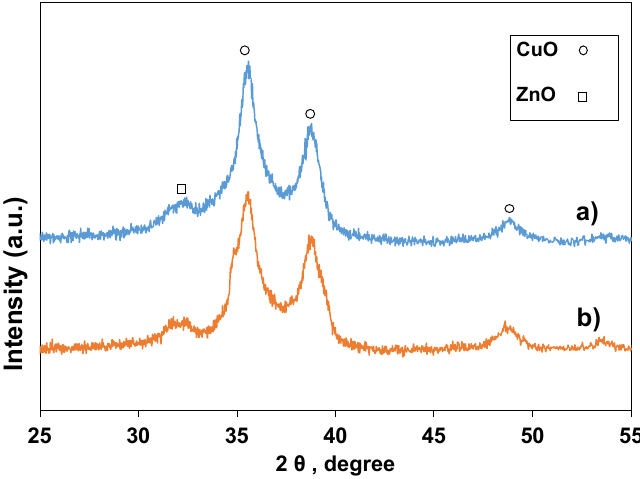
Figure 3. X-ray diffraction (XRD) profiles for the calcined catalysts: ( a ) 2Pd-CZA; ( b ) CZA. CZA: Cu/Zn/Al (molar) = 35/35/30. All traces have been displaced for clarity.